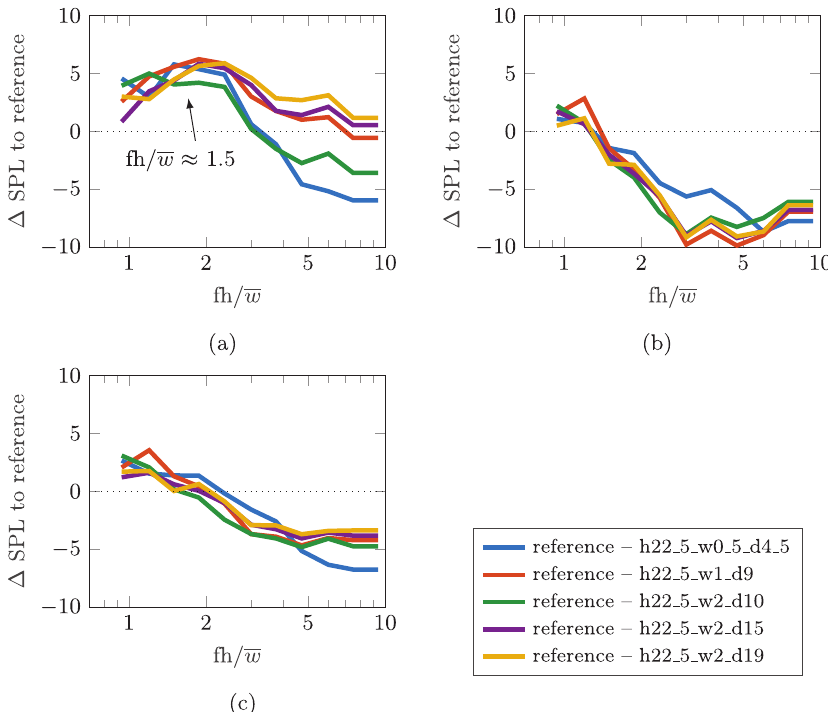
Figure 12. Difference of the integrated one-third octave band spectra from the slitted axial fans to the reference fan as a function _ V ¼ of the dimensionless frequency. Volume fl ow rate 1 : 1 m 3 s (cid:1) 1 and fan rotational speed f R = 24.8 Hz. (a) Leading edge subregions, (b) trailing edge subregions, (c) entire blade